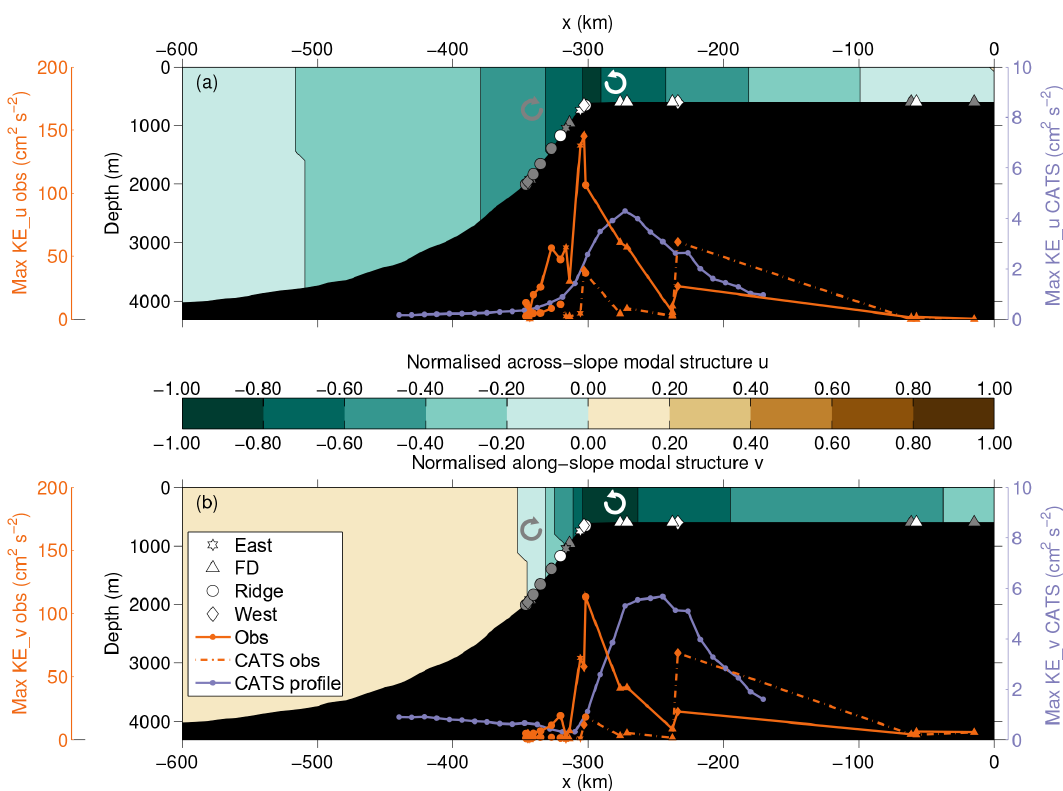
Figure 12. Across-slope sections of the normalised (a) along-slope ( u ) and (b) across-slope ( v ) modal structure from the numerical code (background colours) at the wave number of the RF for reference stratification. Moorings within the modelled domain are indicated by markers whose shapes correspond to the geographic locations (west, ridge, Filchner Depression, east) in Fig. 1. Markers filled in grey (white) indicate a clockwise (anticlockwise) rotational sense of the diurnal tidal currents. For each mooring location, diurnal tidal KE for austral summer is shown, both from observations (solid orange line) and derived from CATS (broken orange line). Diurnal tidal KE predicted from the CATS run along the cross-shelf section through the locations of moorings M1 and M2 (see Fig. 1 for location) is shown as a purple line with markers indicating locations of predicted